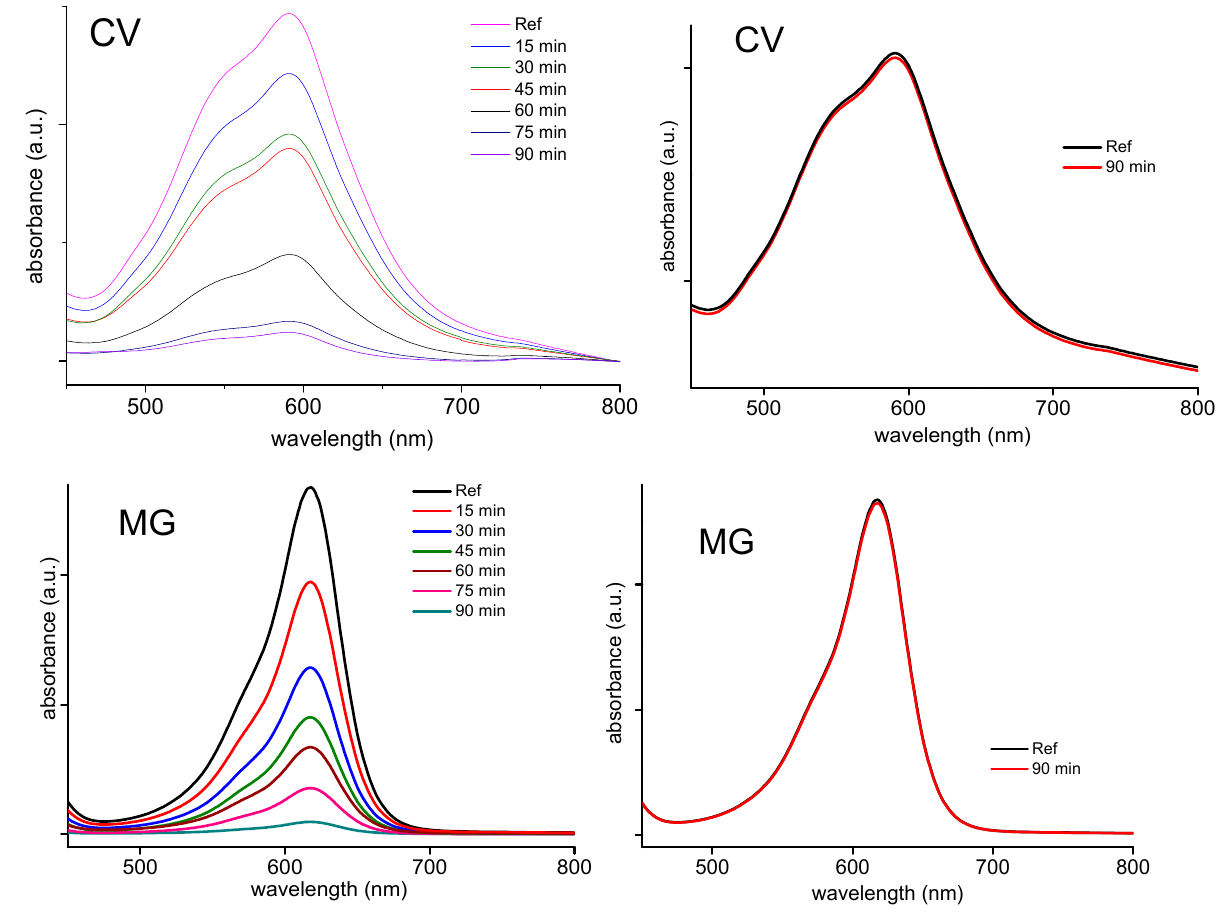
Figure 7. Evolution of the absorbance of malachite green (MG) and crystal violet (CV) over time using 3 mL H 2 O 2 and 5 mg [Co(TMFPP)] and dye concentrations of 25 mg L − 1 , in H 2 O at pH = 8 and T = 298 K (left). Blank tests without catalyst (right).